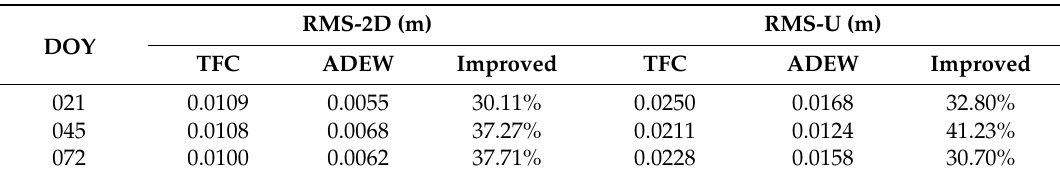
Table 2. Standard deviation (RMS) and improvement value in the horizontal direction (2D) and vertical (U) coordinate error of the 3 different days derived from the TFC and ADEW models. RMS-2D (m) DOY DOY